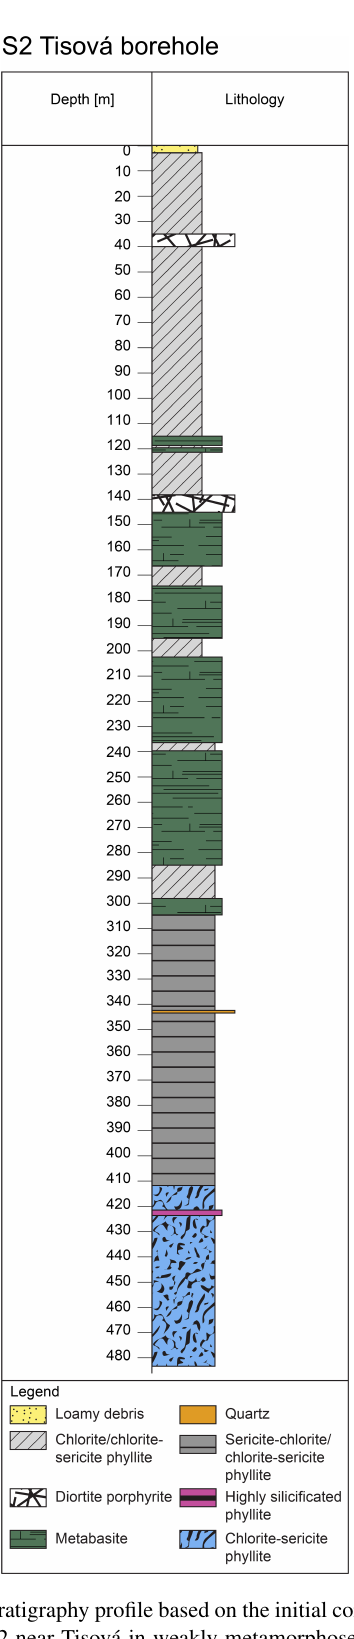
Figure 10. Stratigraphy profile based on the initial core description of borehole S2 near Tisová in weakly metamorphosed Ordovician sediments